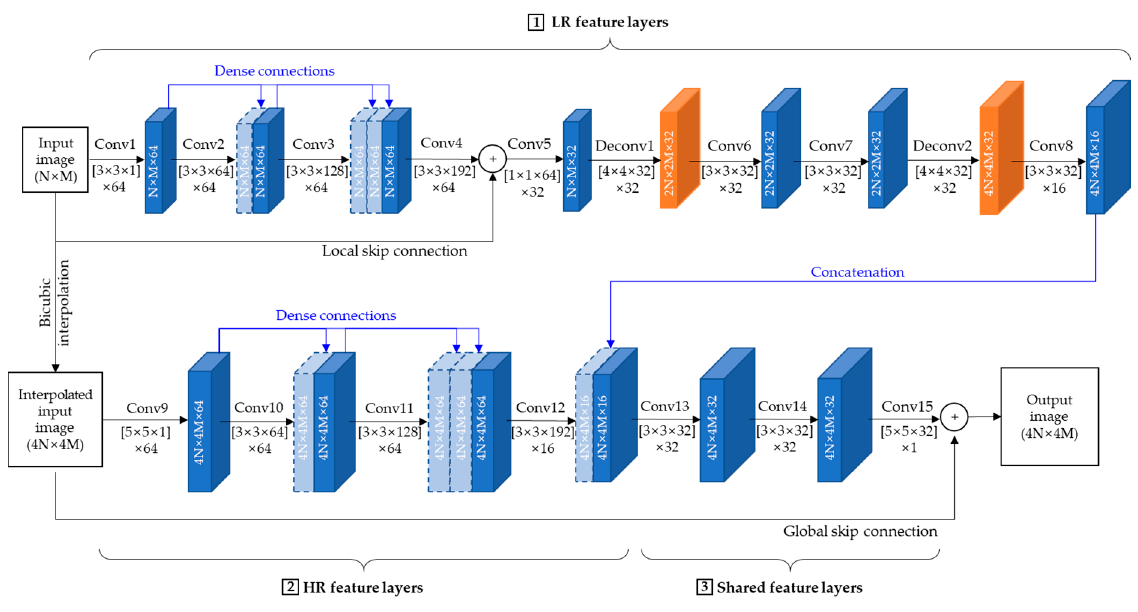
Figure 2. The framework of the proposed SR-ILLNN.